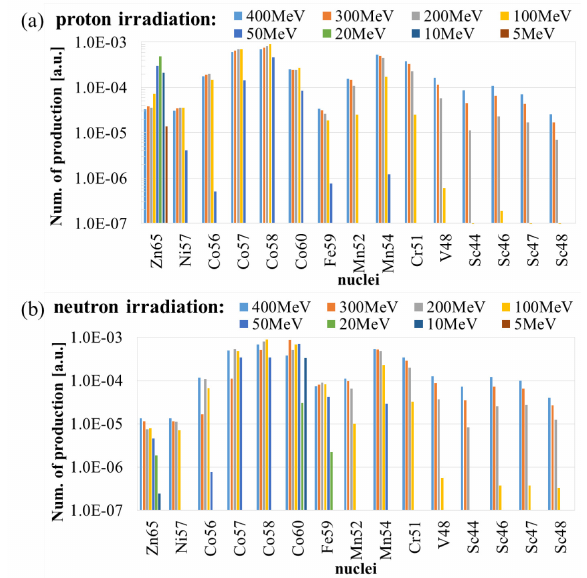
Fig. 11. Estimation of produced nuclei in sample pieces owing to proton and neutron